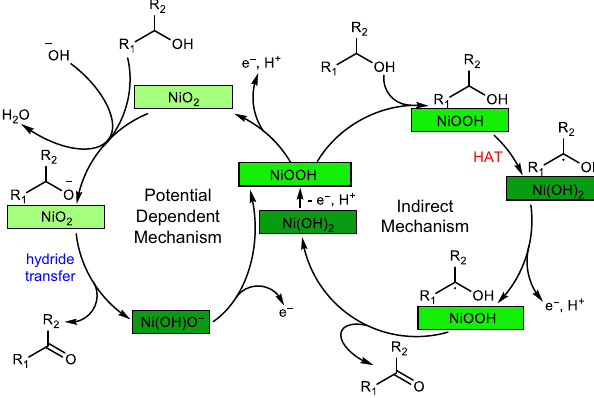
Fig. 2 | Simpli fi ed representations of two possible alcohol dehydrogenation mechanisms on NiOOH electrodes. R 1 , R 2 =aliphatic carbon chain, aromatic car- bon chain, or H. HAT=hydrogen atom transfer. For 2° alcohols, oxidation stops at the ketone product. For 1° alcohols, oxidation may proceed to the carboxylic acid via analogous oxidation of the hydrated geminal diol form of the initially formed